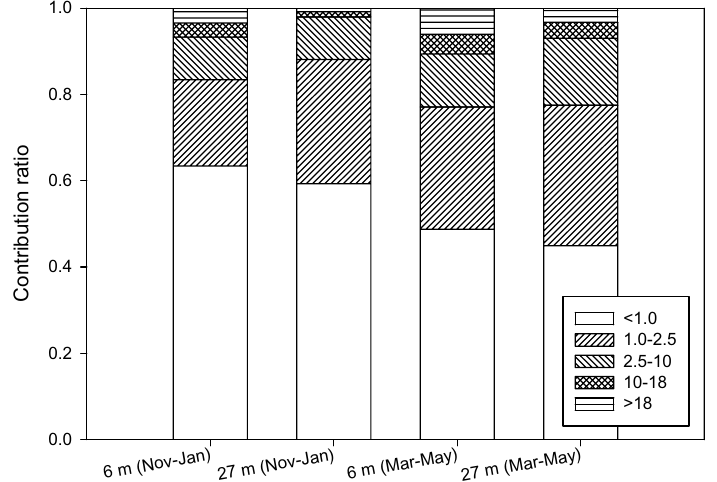
Figure 7. Contributions of the PAH concentrations on the PM with different sizes to total PM-associated PAH concentrations in different samples.